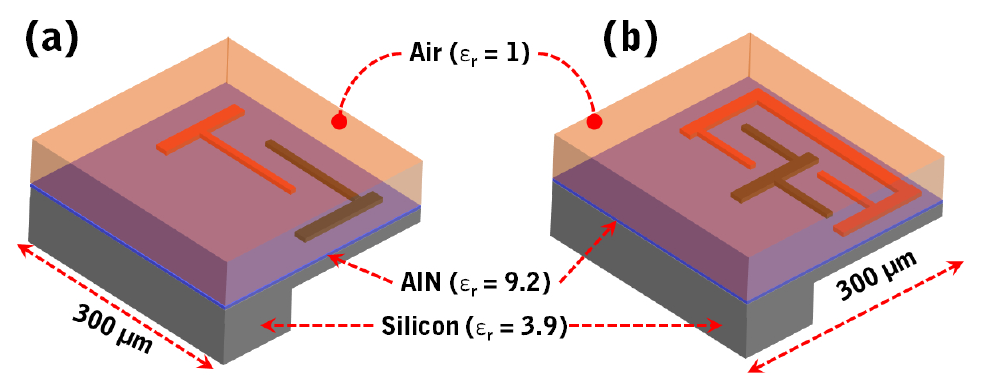
Figure 2. Modeling of unit cells in terms of the acoustic–piezoelectric interaction with the finite element method (FEM) in COMSOL: ( a ) unit cell of regular D33 mode, and ( b ) unit cell of proposed D33